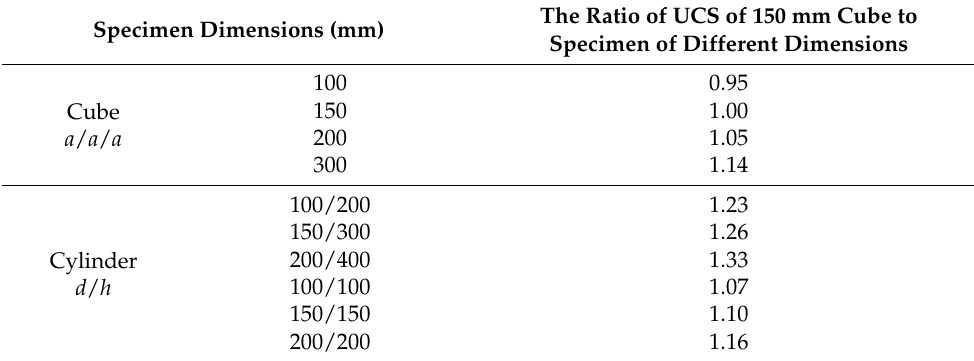
Table 2. UCS of concrete depending on dimensions and shape of the